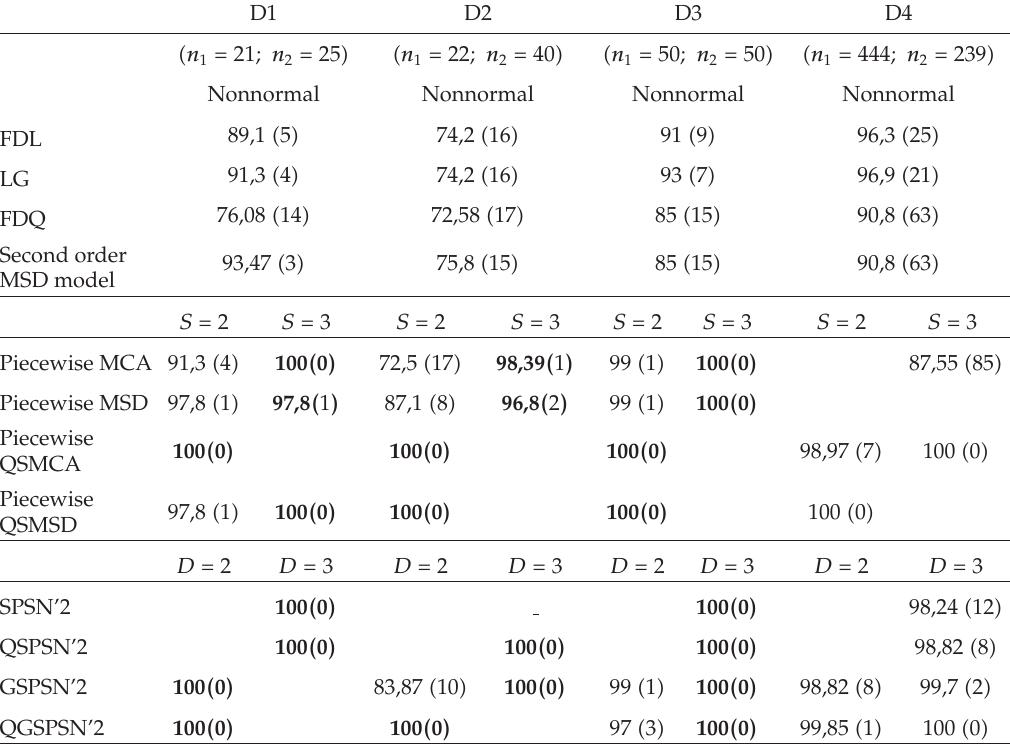
Table 8: The apparent classification rates of the di ff erent models (cid:2) in percentage (cid:3) . D1 D2 D3